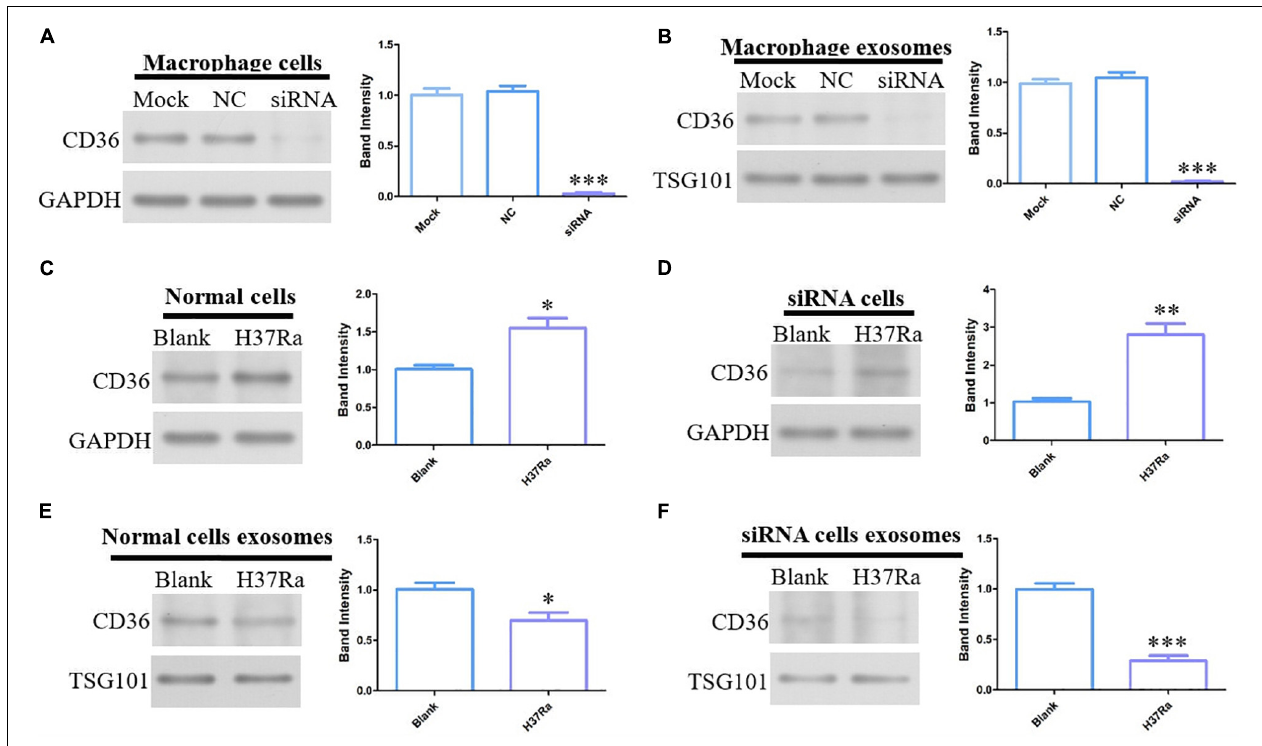
FIGURE 6 | CD36 expression in H37Ra-infected macrophages or exosomes determined by western blotting. (A) CD36 in macrophages was knocked down using siRNA. (B) CD36 expression was analyzed in exosomes derived from CD36-knockdown macrophages. (C,D) CD36 expression was promoted in H37Ra-infected macrophages and CD36-knockdown macrophages. (E,F) H37Ra infection suppressed the expression levels of CD36 in macrophages and CD36-knockdown macrophages. * p < 0.05, ** p < 0.01, *** p <